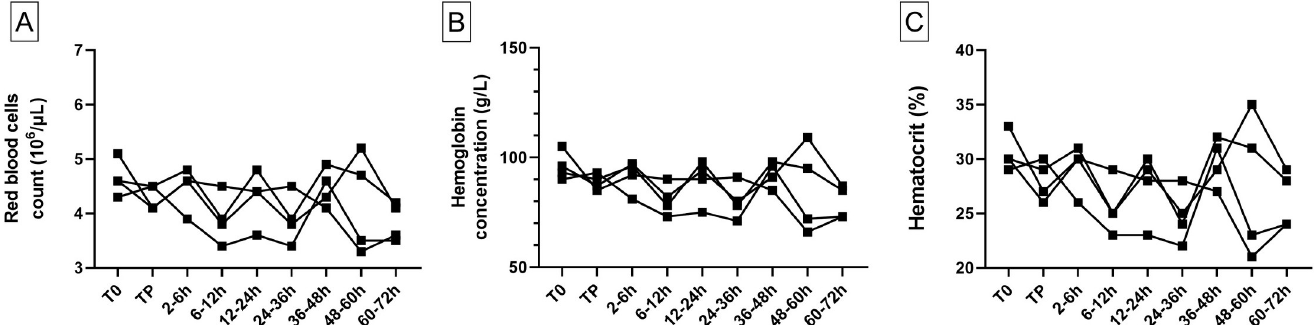
Fig 3. RBC count, hemoglobin and hematocrit animal values in the cardiac model (n = 4). RBC count (A), hemoglobin (B) and hematocrit (C) are represented for each individual animal. The different times of sampling are during anesthesia before blood loss (T0), after autologous transfusion at the end of anesthesia (TP), then during the 72 h survival follow-up period (7 sampling times following the end of the transfusion).